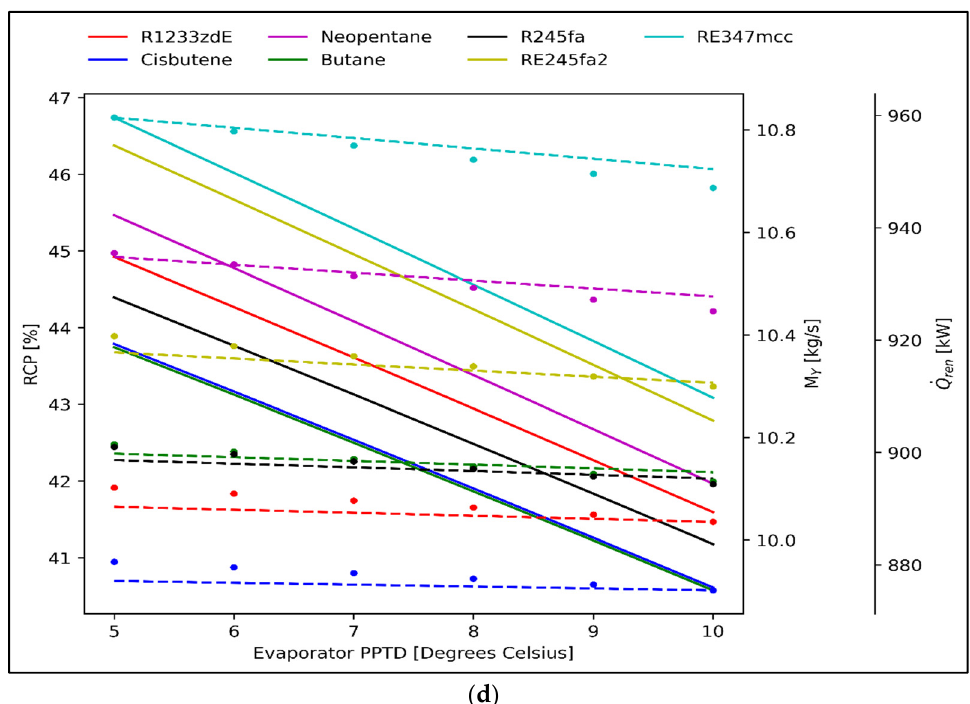
Figure 9. ORC evaporator pinch point temperature difference vs. reduction in power consumption and renewable energy input ( a ) at 90 °C; ( b ) at 100 °C; ( c ) at 110 °C; and ( d ) at 120 °C. Solid Lines: . RCP , Dots: Q ren , Dashed Lines: M Y